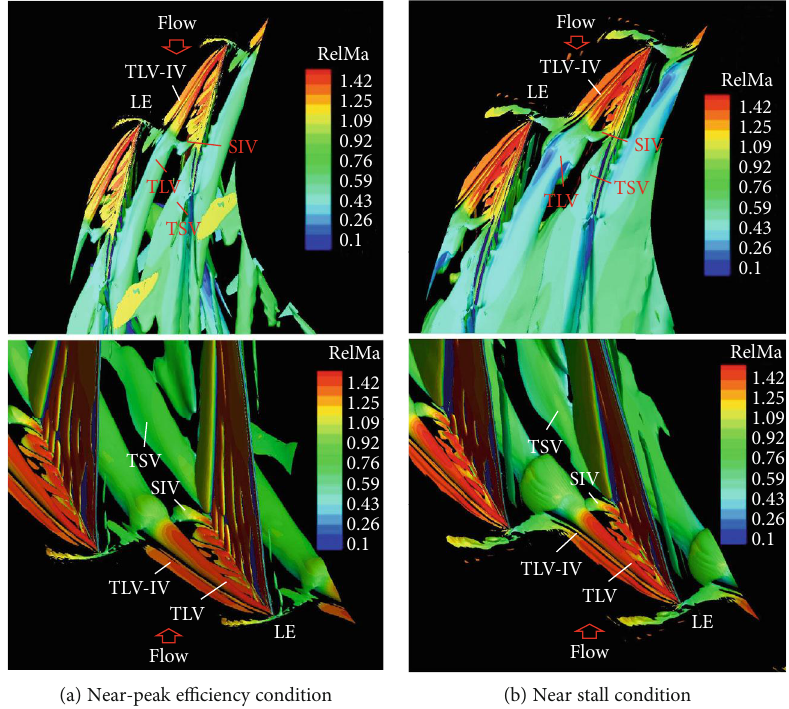
Figure 16: Vortex systems near the blade tip region at near-peak e ffi ciency and near stall conditions for NASA Rotor